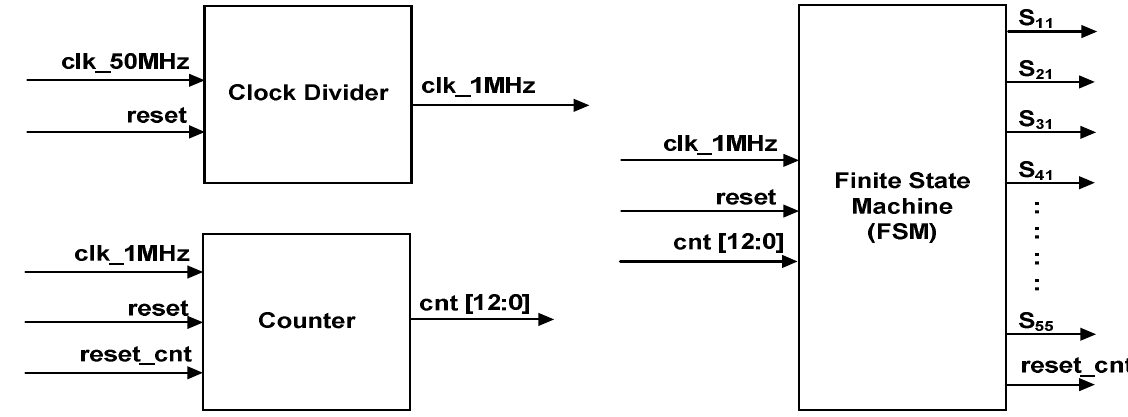
Figure 7. Internal architecture of the SHE digital switching controller.